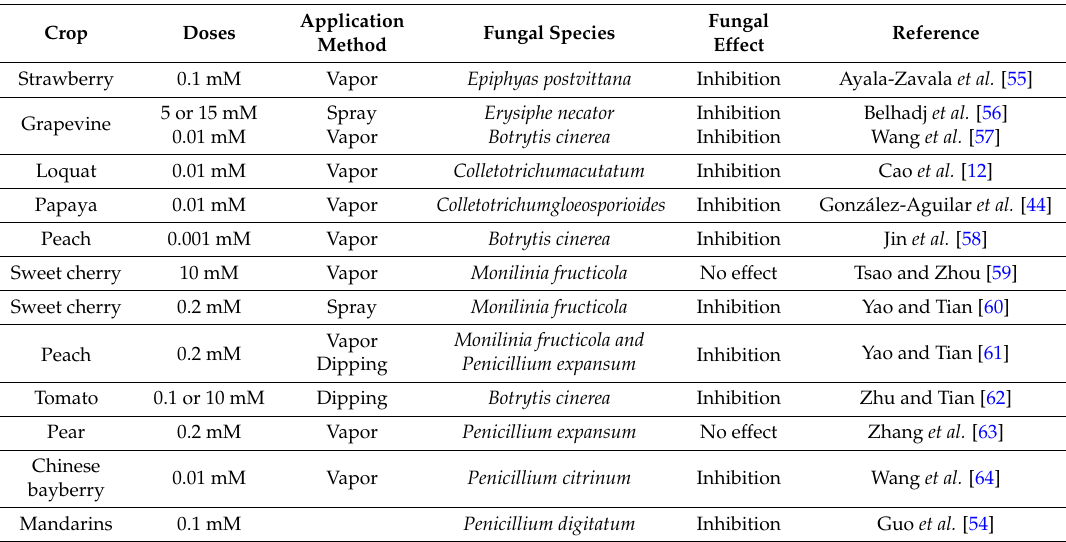
Table 1. Effect of MeJA applications on post-harvest fungal diseases of